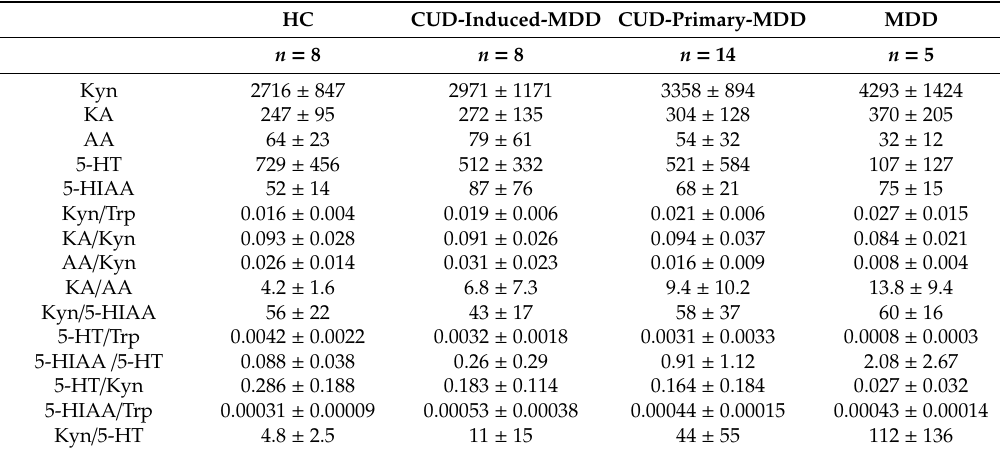
Table2. Basal values for the serotonin–kynurenine pathways (ng / mL for concentrations and adimensional for ratio values).